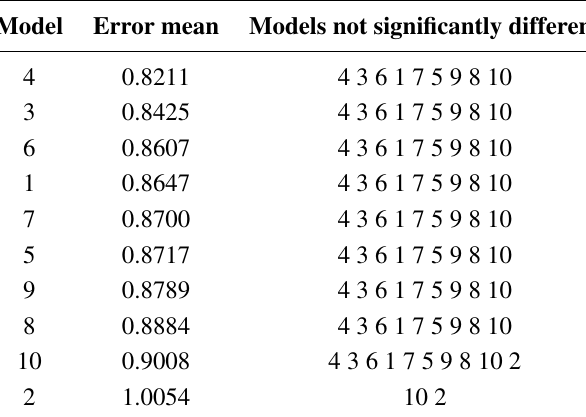
Table 9. Bonferroni’s test